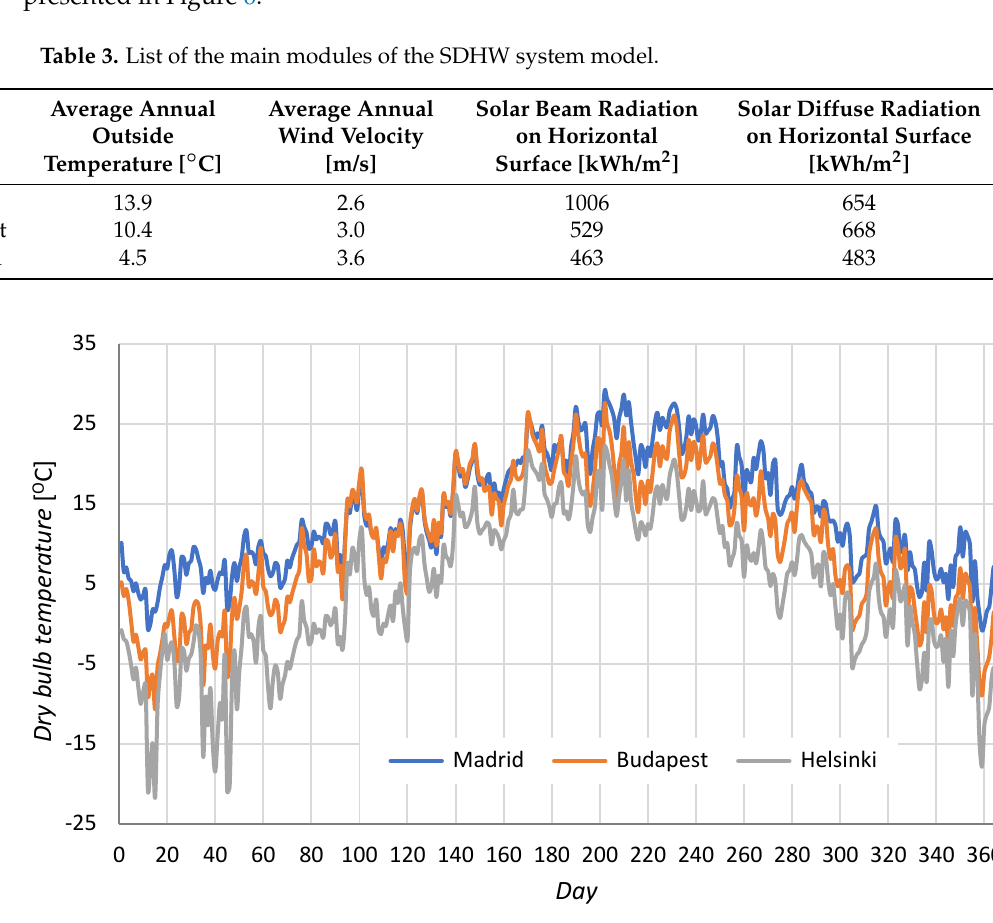
Figure 4. Average daily dry bulb temperature.